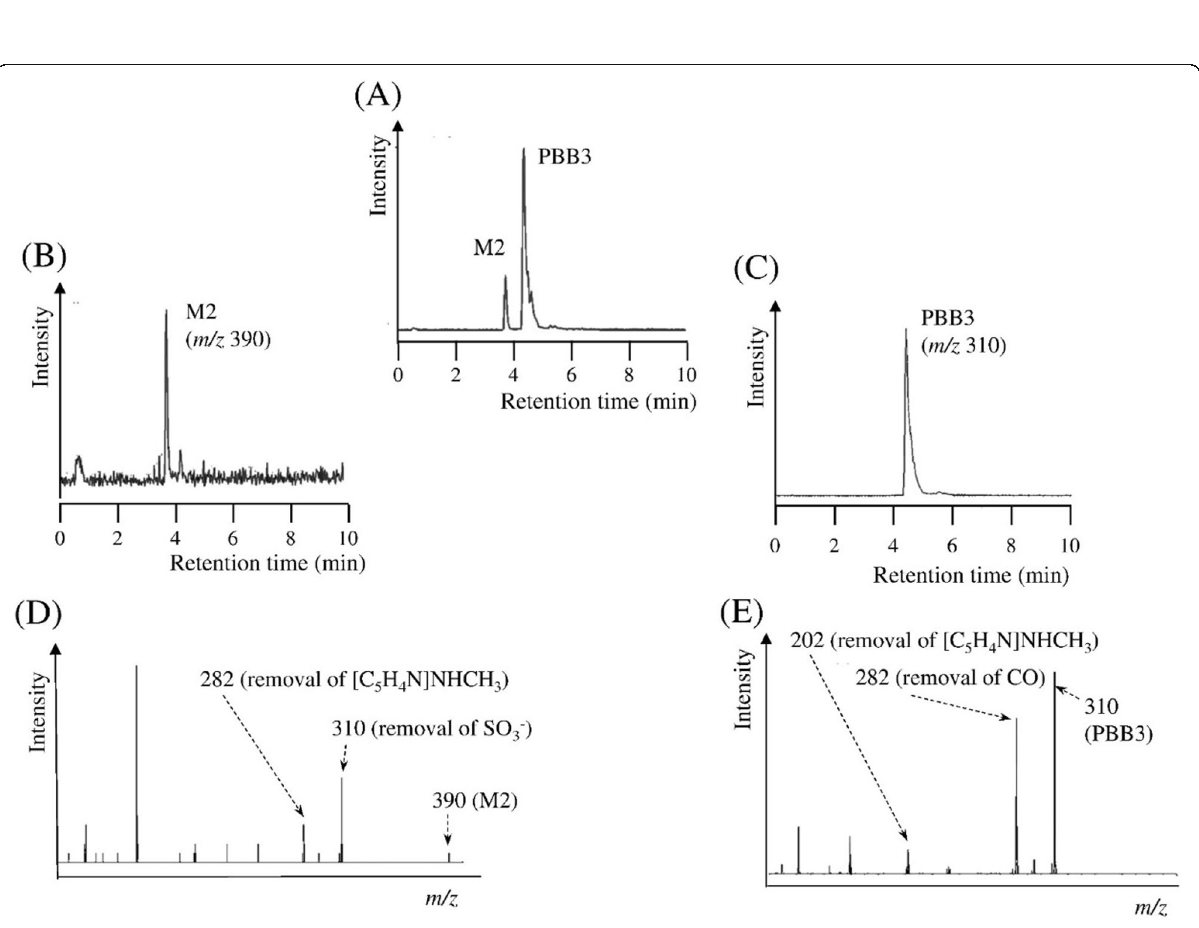
Fig. 3 (a) Mass chromatograms of in vivo metabolite analysis using carrier-added [ 11 C]PBB3 in mouse plasma. Enhanced product ion chromatograms of the major metabolite M2 ( m/z 390, ( b ) of PBB3 and PBB3 ( m/z 310, ( c ). MS – MS fragmentation patterns of M2 ( d ) and PBB3 ( e ). Adapted with permission from Ref.